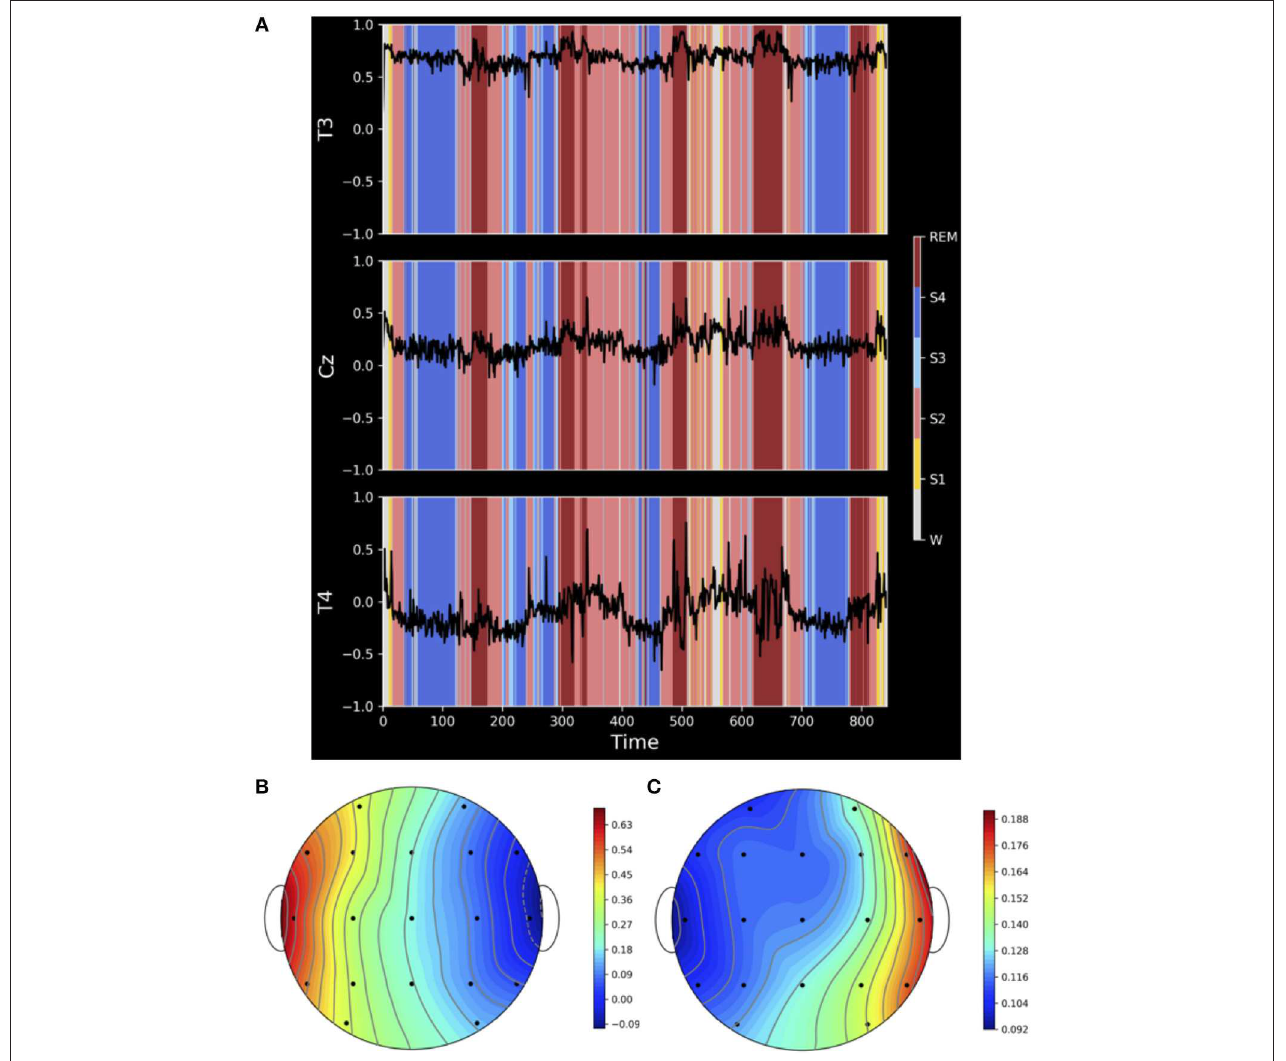
FIGURE 4 | (A) Correlation coefficient between the earlobe A1 and active electrodes T3, Cz and T4 estimated with a running window of length 3,840 data points (corresponding to 30 s) over the whole night recording of a clinically healthy, 26-year-old male subject. Sleep stages (W = awake, S1–S4 denotes sleep stages 1–4 and REM denotes Rapid Eye Movement sleep periods) are indicated by colored shadows in each panel. (B) Shows a heat map of the average correlation between the active electrodes and A1 and (C) the respective standard deviation. Both quantities are estimated over the whole night